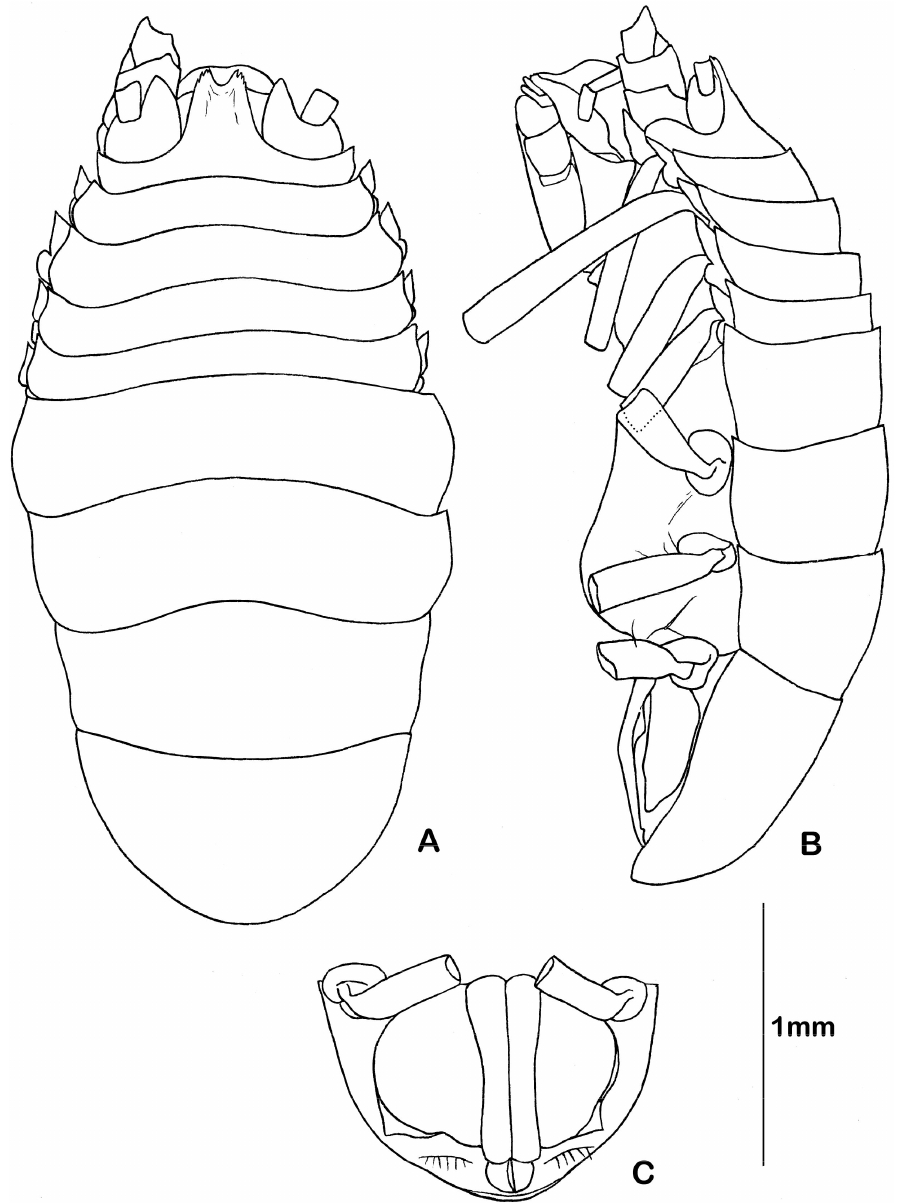
Figure 3. Eurycope producta GO Sars, 1868. Male (ZMH K-45596): ( A ) dorsal view; ( B ) lateral view; ( C ) pleotelson, ventral